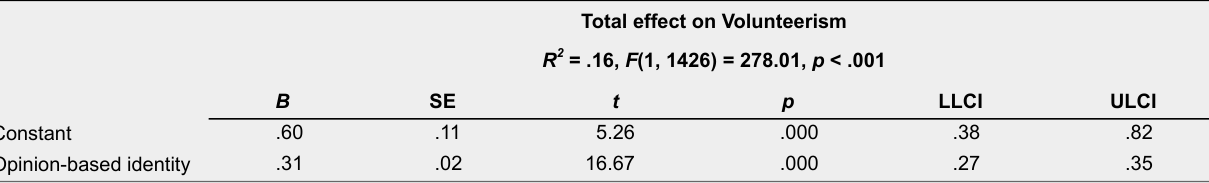
Analyses of Moral Convictions, Efficacy Beliefs, and Anger as Mediators in the Relationship Between Opinion-Based Identity and Either Volunteerism or Political